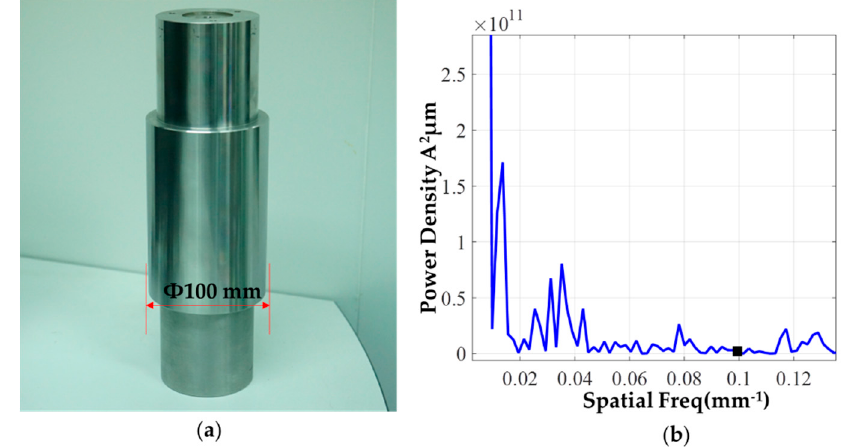
Figure 12. Workpiece and its profile spatial frequency: ( a ) Workpiece after the precision turning progress; ( b ) spatial frequency of a typical circular contour.